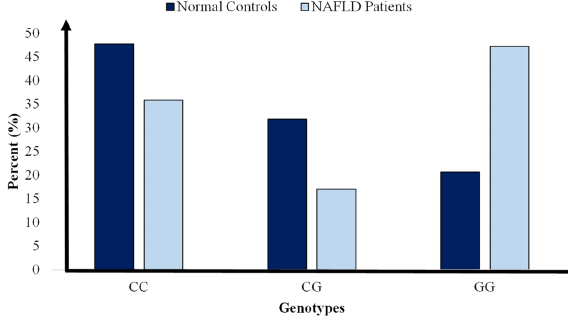
Figure 5. A Comparison Between Genotype Frequencies in NAFLD Patients and Healthy Controls. Note . NAFLD: Non-alcoholic fatty liver disease.